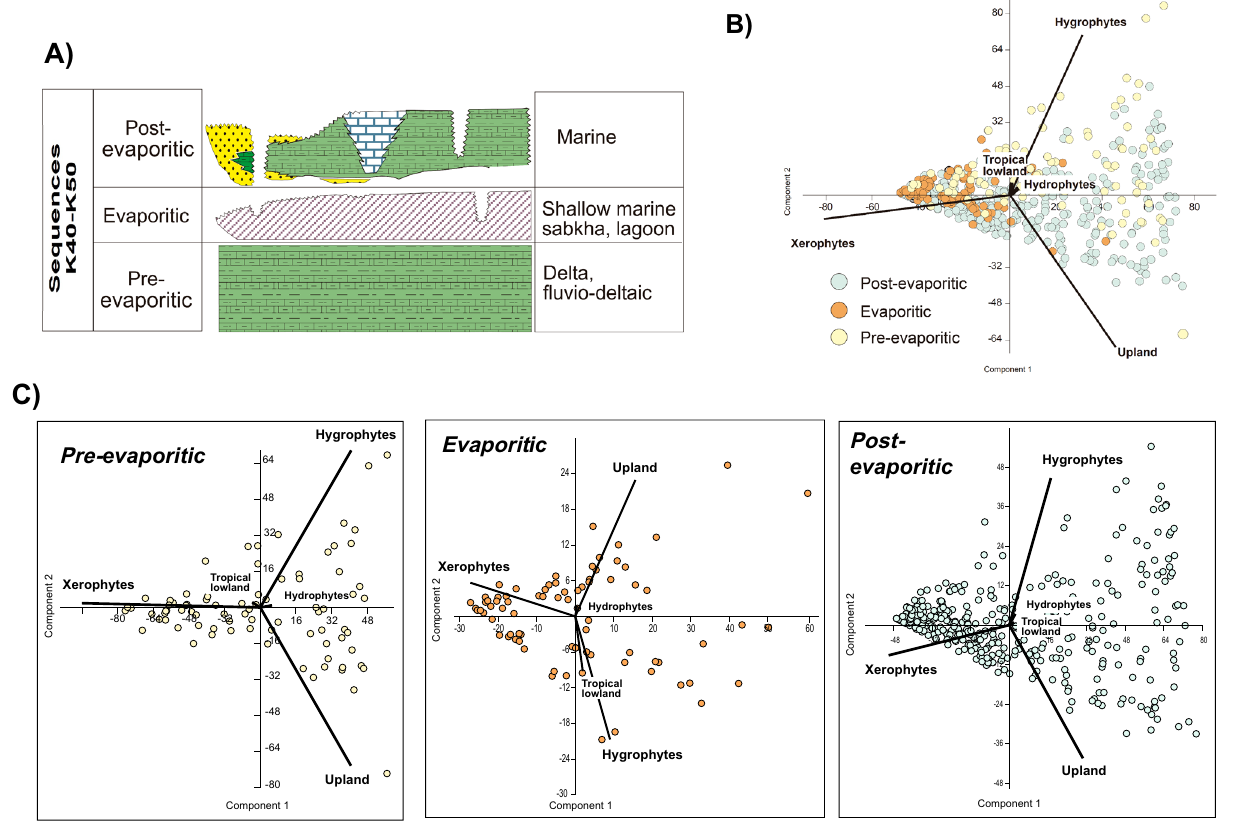
Figure 2. Paleoclimatic phases scheme and principal component analysis for paleoclimatic phases. ( A ) Paleoclimatic phases scheme for the late Aptian and the main depositional environments. ( B ) Principal component plot of bioclimatic groups. ( C ) Principal component for the pre-evaporitic phase ( N = 92 ), evaporitic phase ( N = 78 ), and post-evaporitic phase ( N = 385 ); see Supplementary Fig. 9 for individual